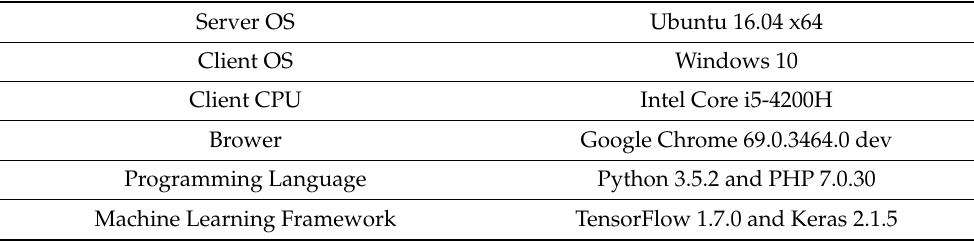
Table 2. Experimental environment.